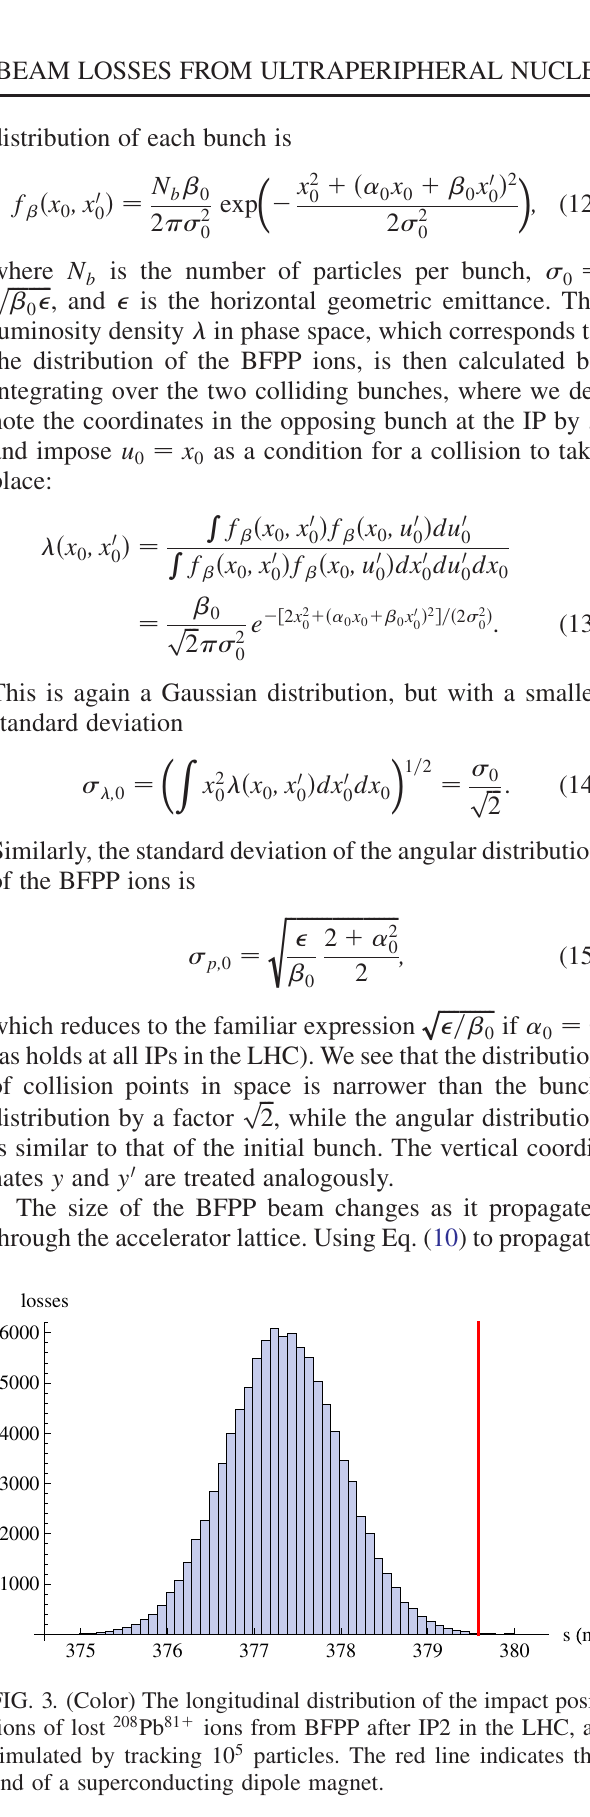
FIG. 3. (Color) The longitudinal distribution of the impact posi- tions of lost 208 Pb 81 þ ions from BFPP after IP2 in the LHC, as simulated by tracking 10 5 particles. The red line indicates the end of a superconducting dipole magnet.